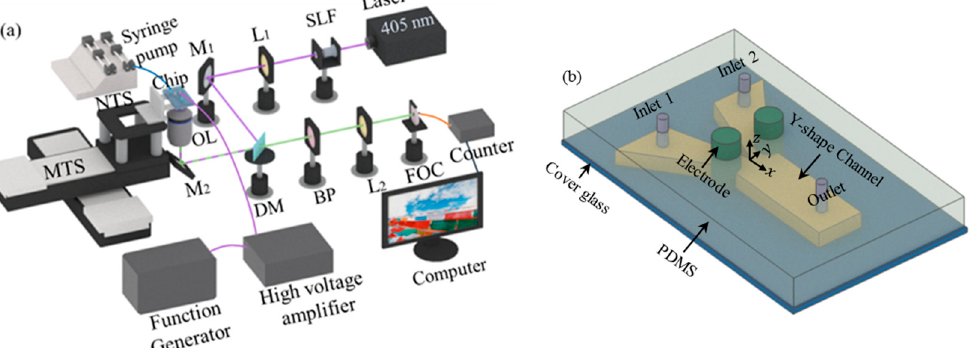
Figure 2. Schematic diagram of the experimental system. ( a ) Schematic of the home-developed con- focal micro-scope, including spatial light filter (SLF), lenses (L), mirror (M1), dichroic mirror (DM), mirror (M2), objective lens (OL), bandpass filter (BPM), nanocube piezo stage (NTC, P-562.3CD, PI), translation stage (MTS, M-521.DG, PI), ( b ) Schematic diagram of the micromixer